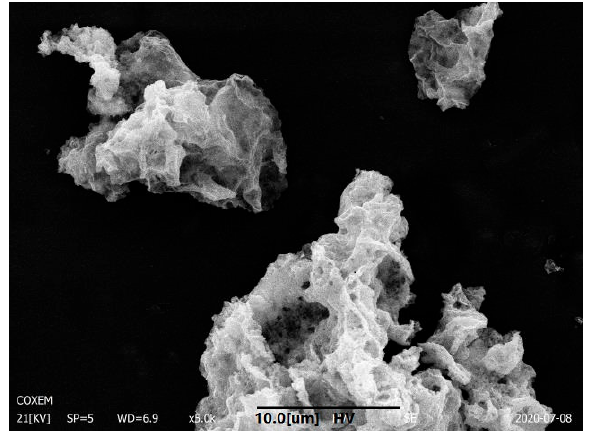
Figure 2. Scanning electron microscope micrograph of (Dy 0.7 Y 0.25 La 0.05 ) 2 O 3 powder prepared by self-propagating high-temperature synthesis (SHS).